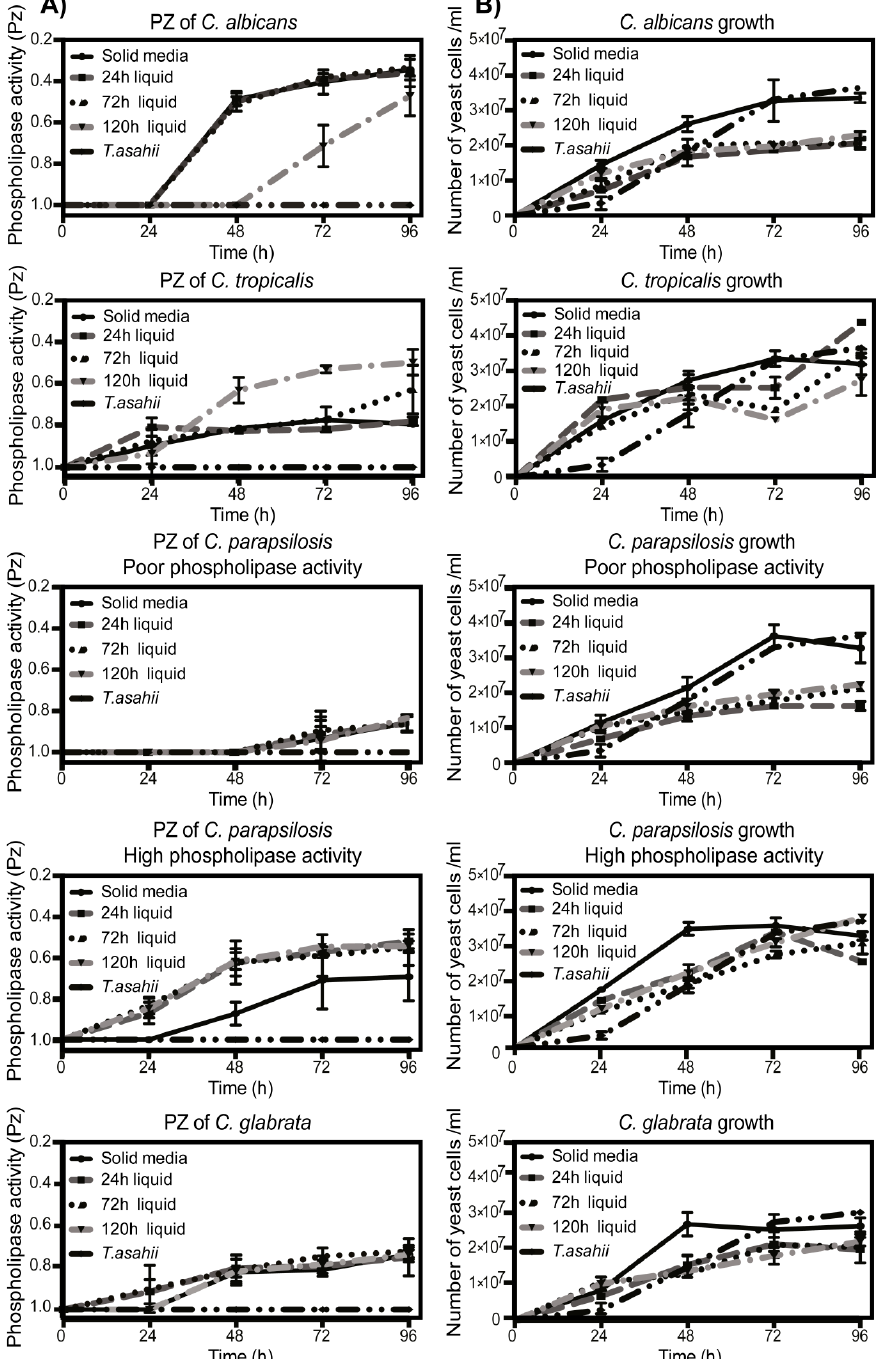
Figure 4. Growth conditions modify phospholipases production kinetics in Candida spp. Candida spp. were grown on solid medium without pre-culture, or were pre-cultured in liquid medium for 24, 72, or 96 h, after which growth was measured at 600 nm, and the amount of fungi was adjusted to 1 OD and then seeded on plates containing phospholipases substrate to determine their respective phospholipase activity ( A , left column) by measuring the size of the precipitation halo of activity (Pz index), and growth rate ( B , right column) by measuring the total diameter of the colony. Precipitation halos measurements were taken every 24 h for 4 days. Results are representative of three